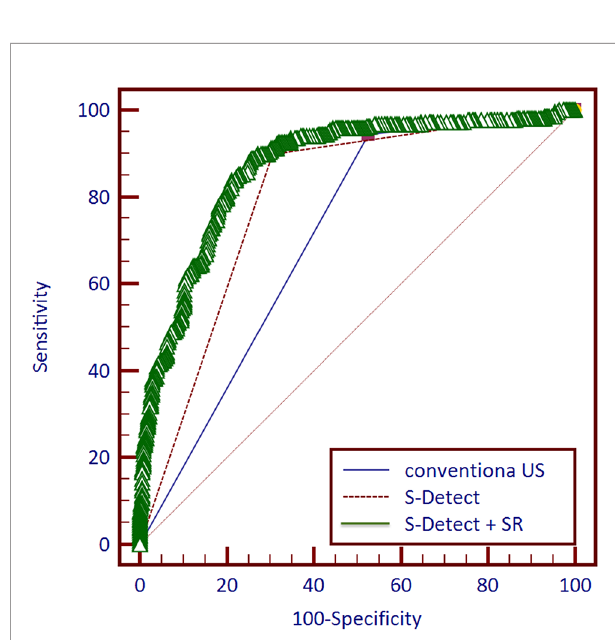
FIGURE 4 | Receiver operating characteristic (ROC) curves of three methods and combined diagnosis for 521